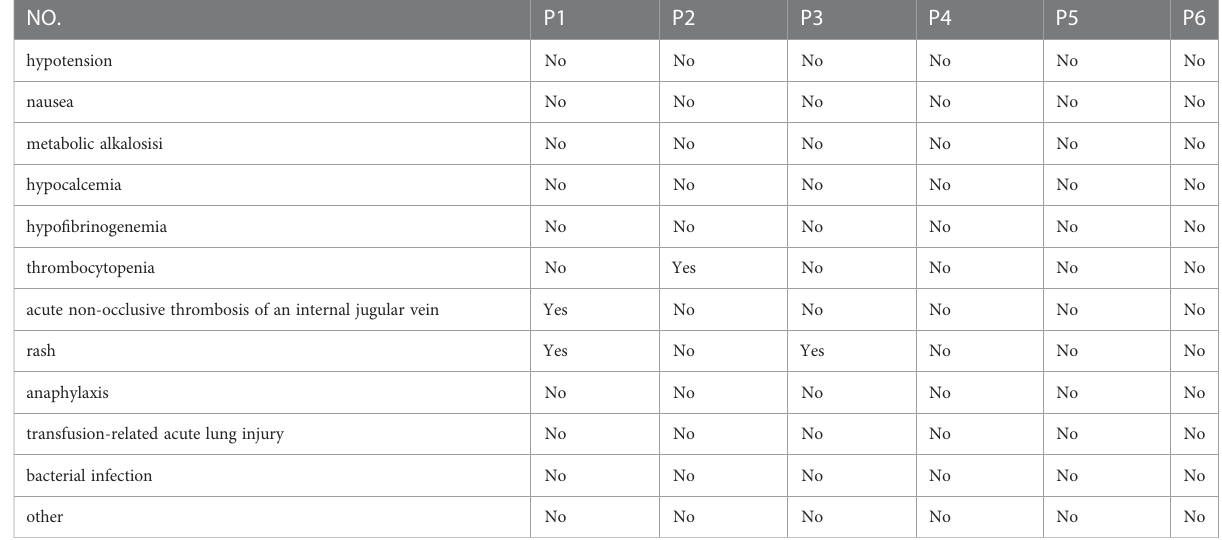
TABLE 3 Adverse events associated with PE